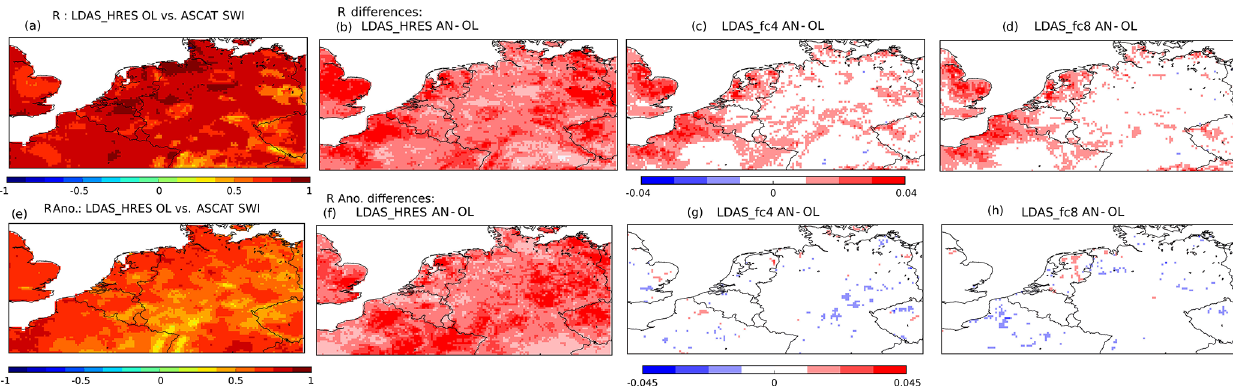
Figure 16. (a) R values between LDAS_HRES open-loop and ASCAT SWI estimates over 2017–2018 for the WEUR domain; (b) R differences between LDAS_HRES analysis (open-loop) and ASCAT SWI. (c) and (d) : same as (b) between LDAS_fc4 initialized by the analysis (open-loop) and LDAS_fc8. Bottom row: same as top row for R values based on anomaly time series.